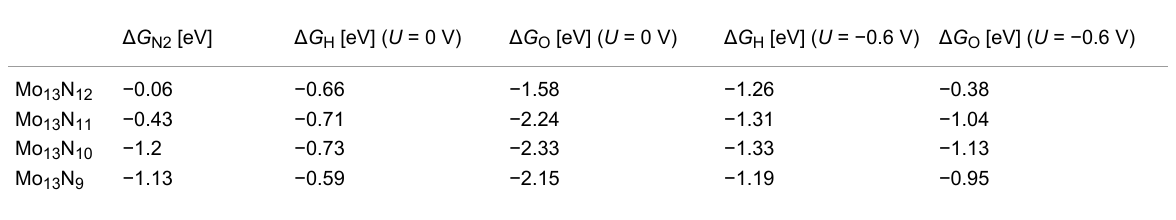
Table 1: Stability of nitrogen, hydrogen and oxygen with ( U = − 0.6 V) and without ( U = 0 V) an applied potential at nitrogen vacancy sites on Mo 13 N x nanoclusters. The potential required to produce ammonia electrochemically at partially nitrogen covered molybdenum nanoclusters was shown to be U = − 0.6 V [2]. The energies are given with respect to H 2 O (g), H 2 (g) and N 2 (g). (The values for Δ G N2 , Δ G H ( U = 0 V) and Δ G H ( U = − 0.6 V) are taken from [2]).